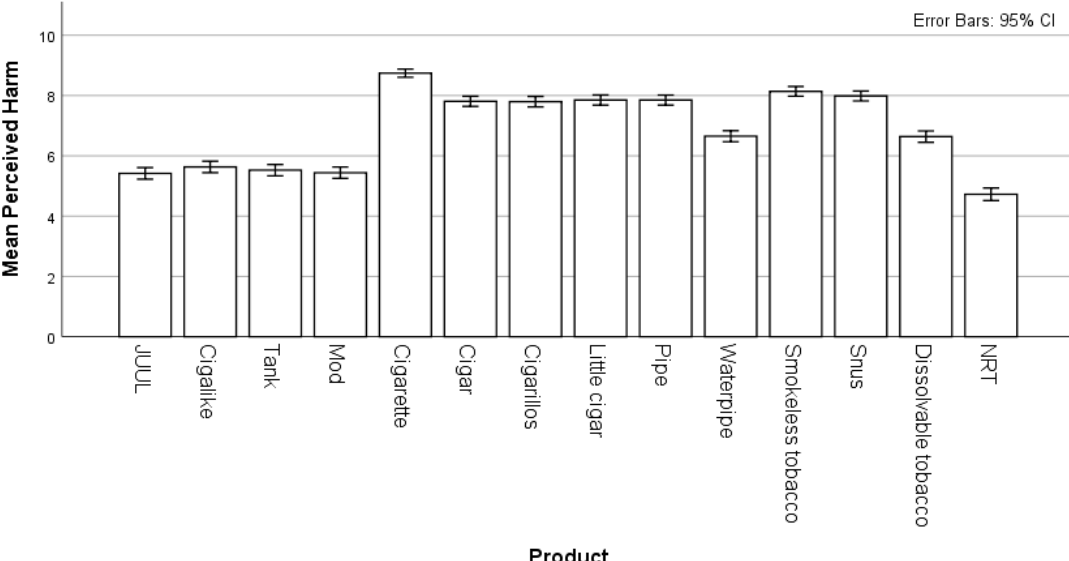
Figure 1. Absolute perceived harm of tobacco products and nicotine replacement therapy compared to the absolute perceived harm of JUUL. Absolute perceived harm was measured on a scale from 0 (not harmful at all) to 10 (extremely harmful).